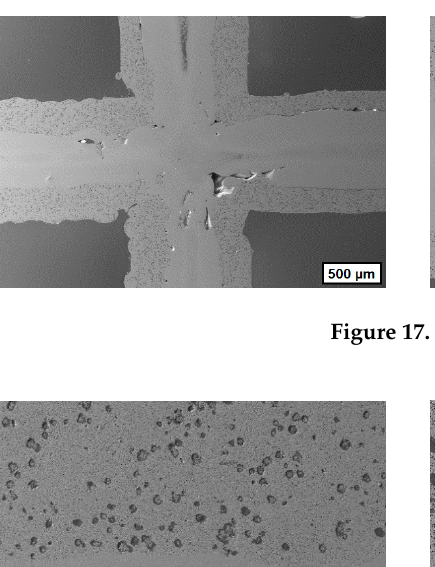
Figure 16. Sintered honeycombs manufactured with different suspensions: ( a ) A&F, ( b ) C&G, and ( c ) C&G.